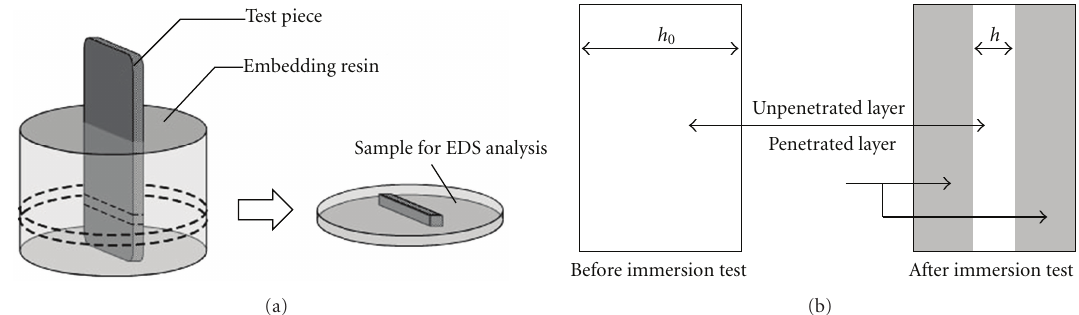
Figure 4: Schematic diagrams of sample (a) and typical micrograph (b) of EDS analysis.